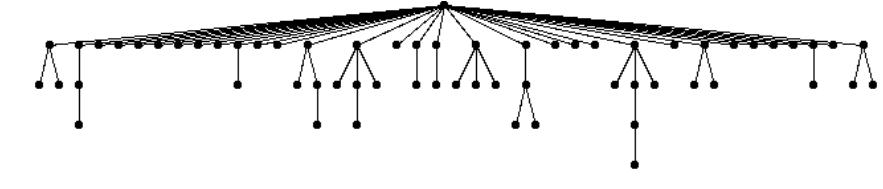
Fig. 12: A random planar tree of internal path length